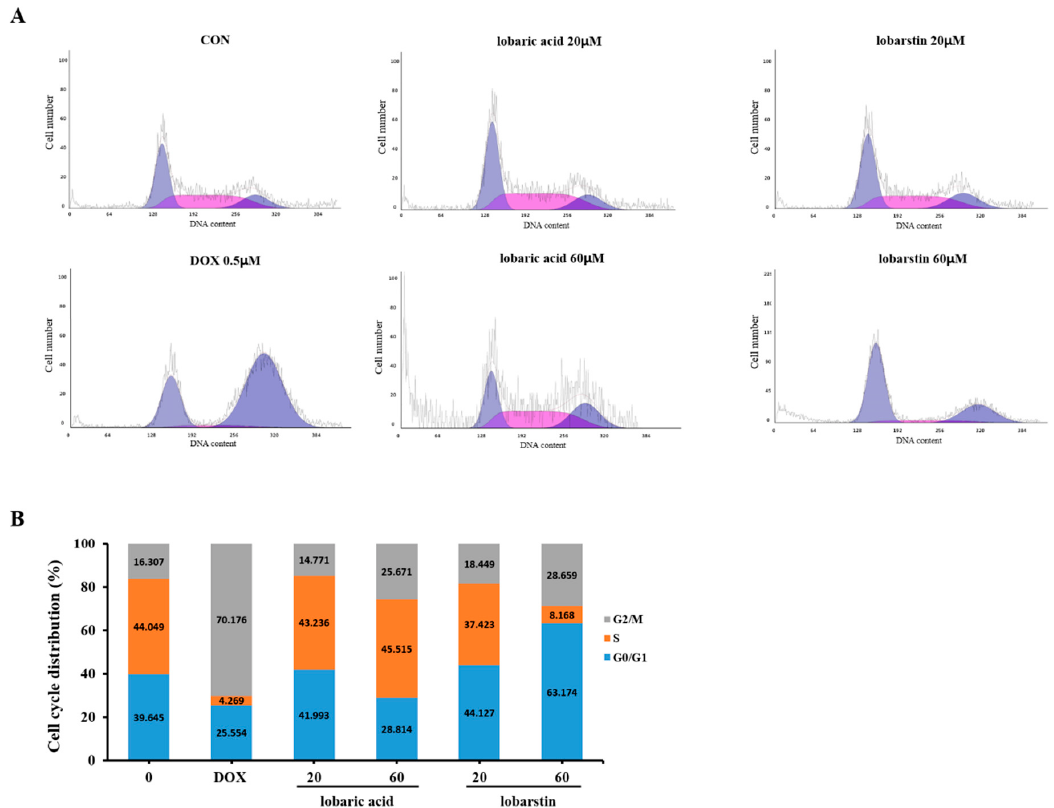
Figure 6. Effect of lobaric acid and lobarstin on HCT-116 cell cycle distribution. ( A ) HCT116 cells were treated with lobaric acid and lobarstin for 24 h, stained with propidium iodide (PI), and analyzed using a flow cytometer; ( B ) the histogram indicates the percentages of total cells in each phase of the cell cycle.